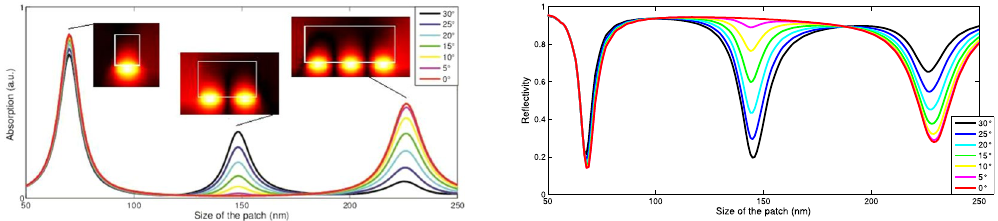
Figure 5. Absorption spectrum for a silver nanopatch of variable width (in nm) from the model (left) and from the reference code (right). The layer is 5 nm thick, the wavelength 950